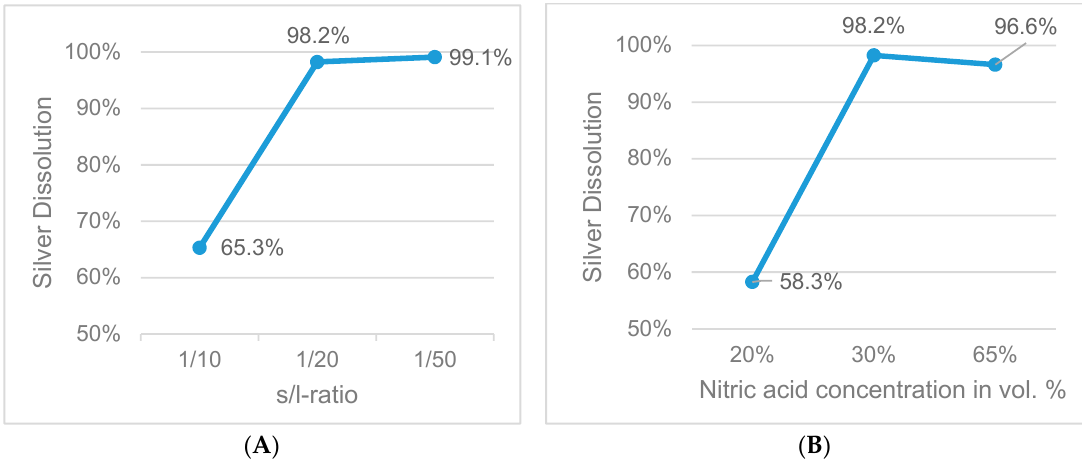
Figure 9. Influence of s/l-ratio ( A ) and acid concentration ( B ) on silver dissolution (fixed parameters: 1 h leaching duration, 65 °C).